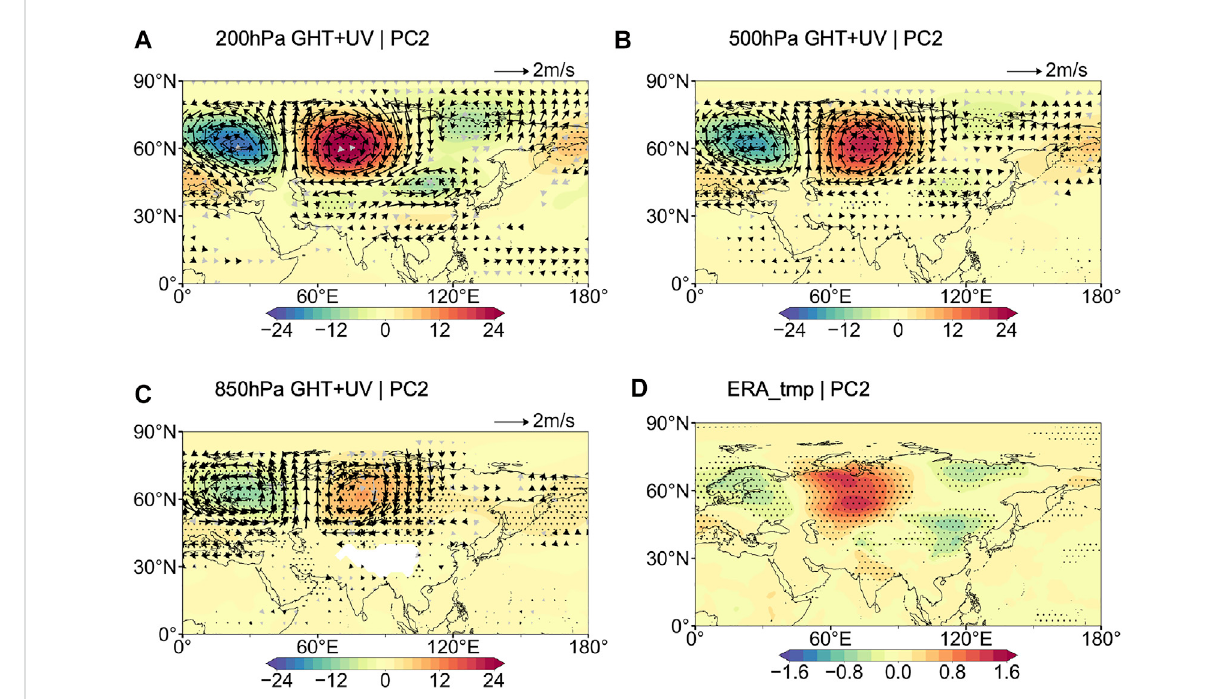
FIGURE 9 Regression maps of (A) 200 hPa, (B) 500 hPa, and (C) 850 hPa geopotential height (GHT, color) and wind (vector), and (D) ERA_tmp onto PC2. Black dots marks regions where GHT differences are above 90% con fi dence level. The black vectors show the wind differences are over 90% con fi dence level. The wind and geopotential data at 850 hPa on the Qinghai-Tibet Plateau are